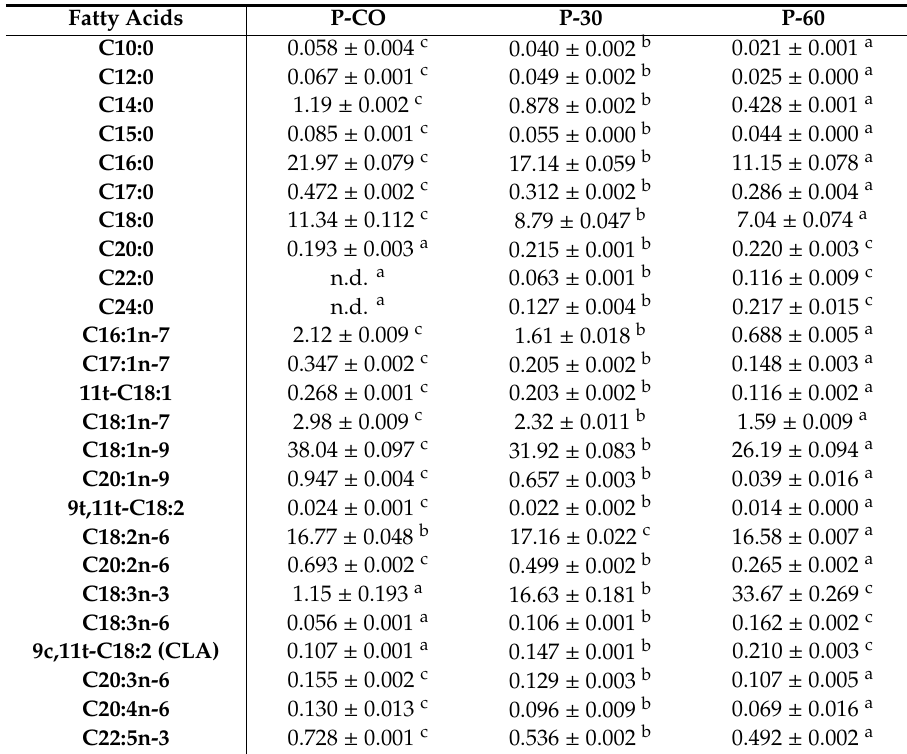
Table 2. Fatty acid composition of p â t é samples (P-CO: control sample; P-30 and P-60: samples with 30% and 60% of pork fat replacement,